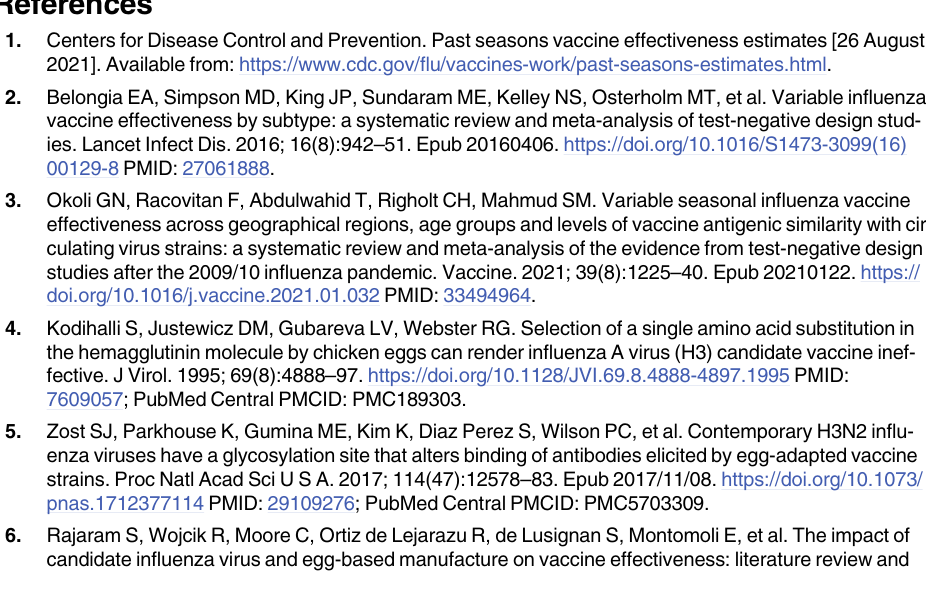
S1 Table. H3N2 components of WHO-recommended influenza vaccines for influenza sea- sons between 2008 and 2023. S2 Table. H3N2 genes that were used in this study. S3 Table. Frequencies of mutations in egg-passaged viruses that showed an average fre- quency of > 10% in the fifth passage. S4 Table. Information of HA from human H3N2 strains with or without